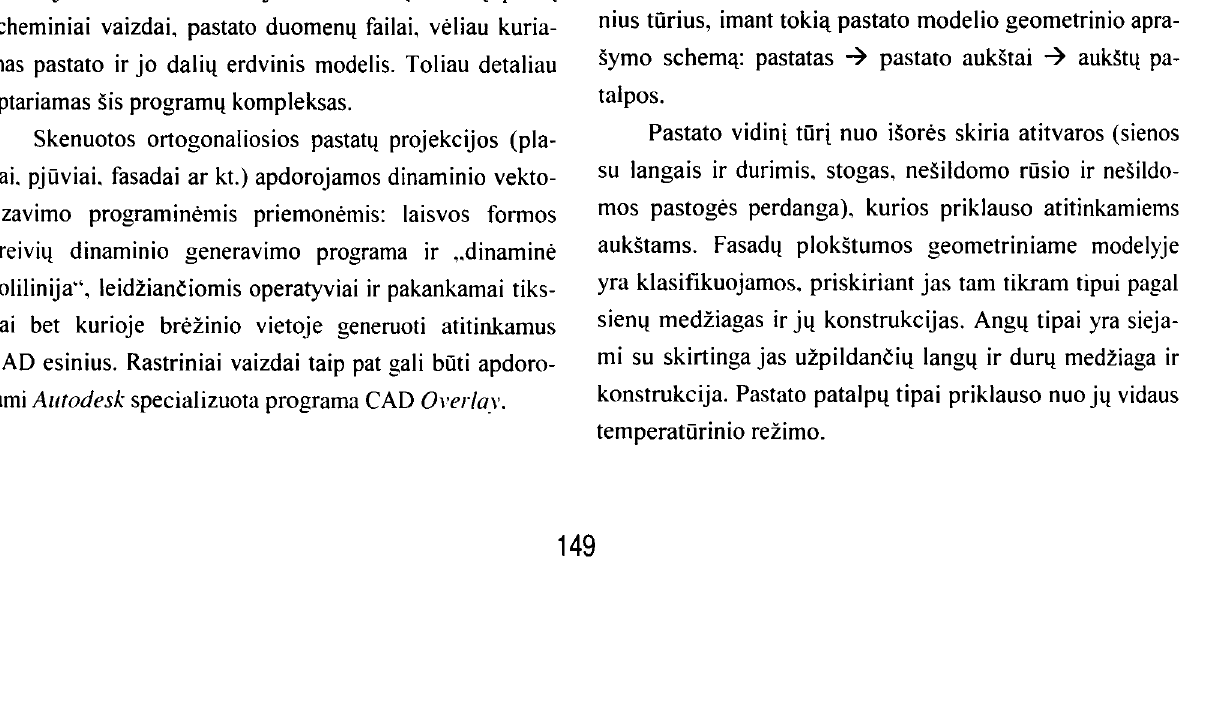
tumos gali biiti konvertuojamos ir i Region tipo grafinius